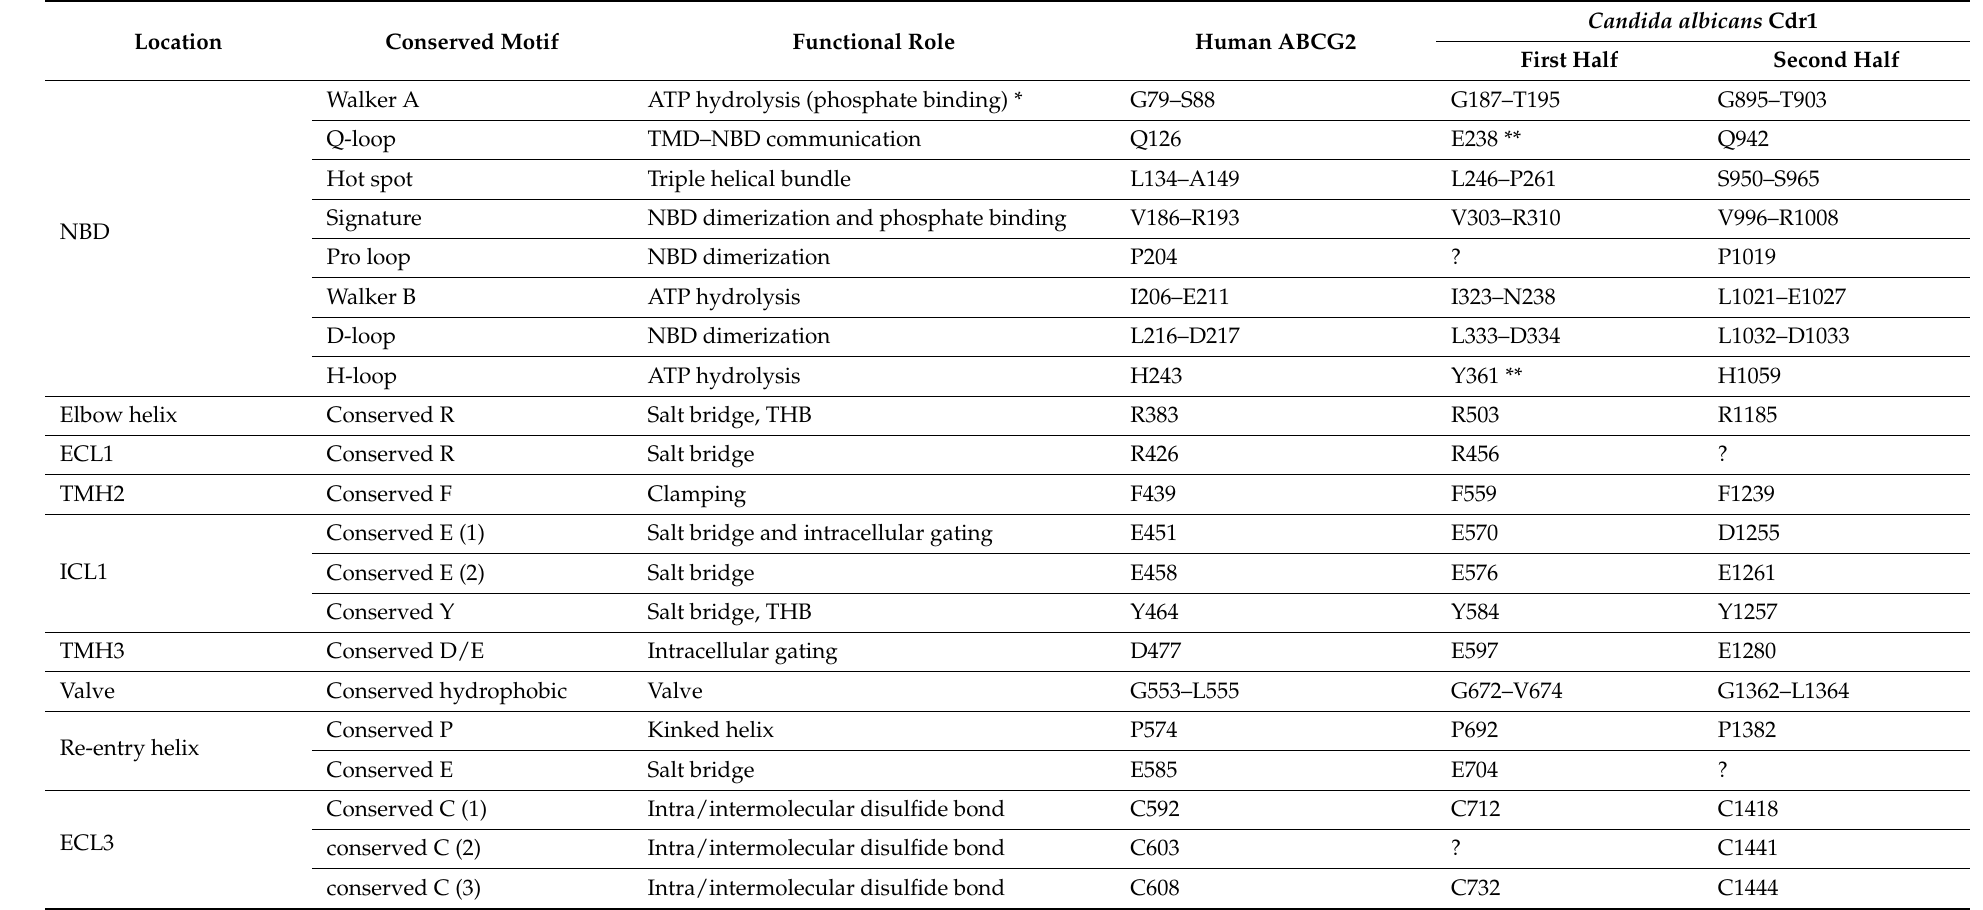
Table 4. The human ABCG2 and fungal Cdr1 multidrug exporters share conserved